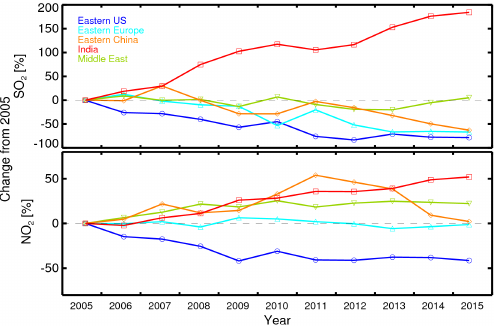
Figure 8. Percent change in OMI annual average columns since 2005: SO 2 (top) and NO 2 (bottom) over the world’s most polluted regions discussed in this